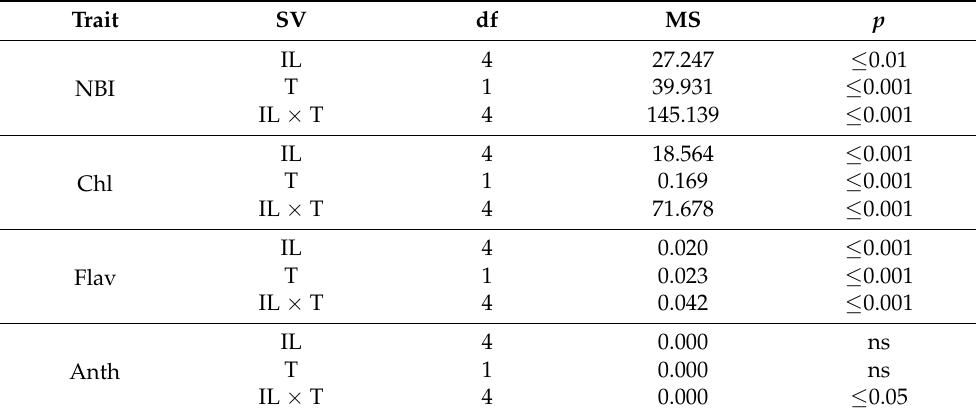
Table 2. Analysis of variance for physiological parameters (i.e., indices) evaluated in maize inbred lines under different water regimes with two replications per treatment. Abbreviations: NBI: nitrogen balance index; Chl: chlorophyll index; Flav: flavonols index; Anth: anthocyanins index; SV: source of variation; IL: inbred line; T: irrigation treatment; d.f.: degree of freedom; MS: mean square; ns: